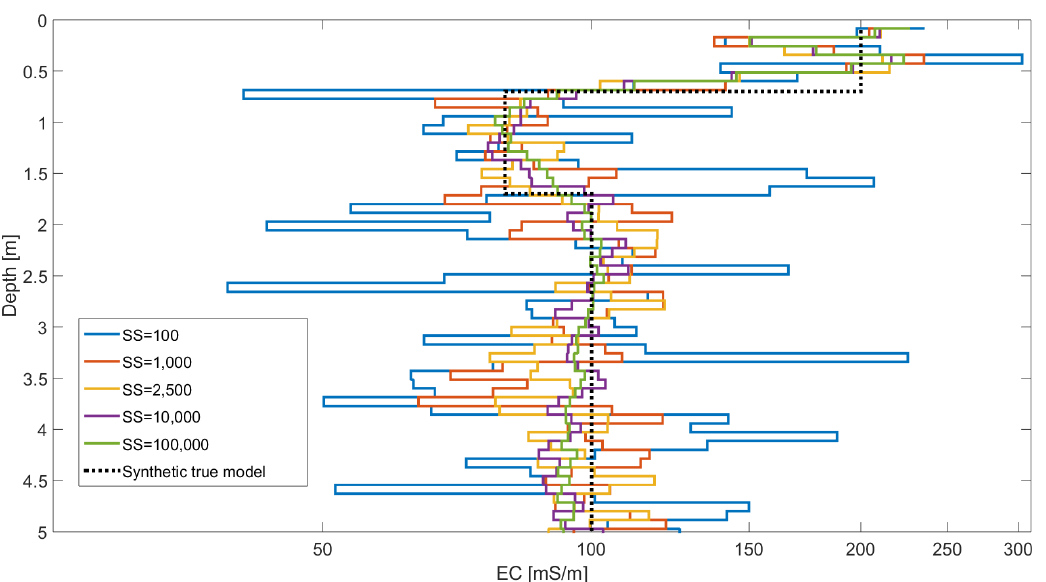
Figure 4. Best fit functions of joint Kalman ensemble generator (KEG) inversion results of FDEM and DC resistivity data for the same synthetic true model using the different sample sizes (SS) for ensemble creation, EC-axis in logarithmic scale.